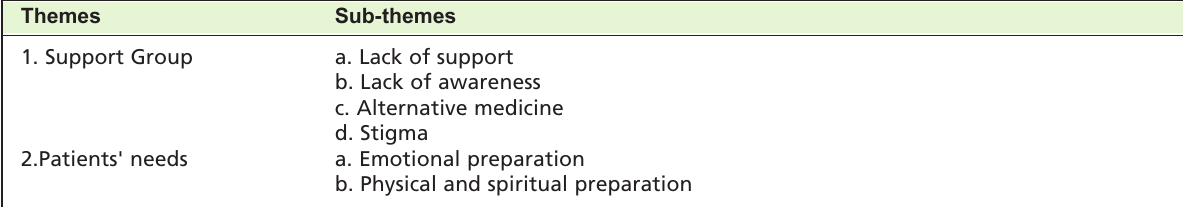
Table V: The themes and sub-themes findings from the